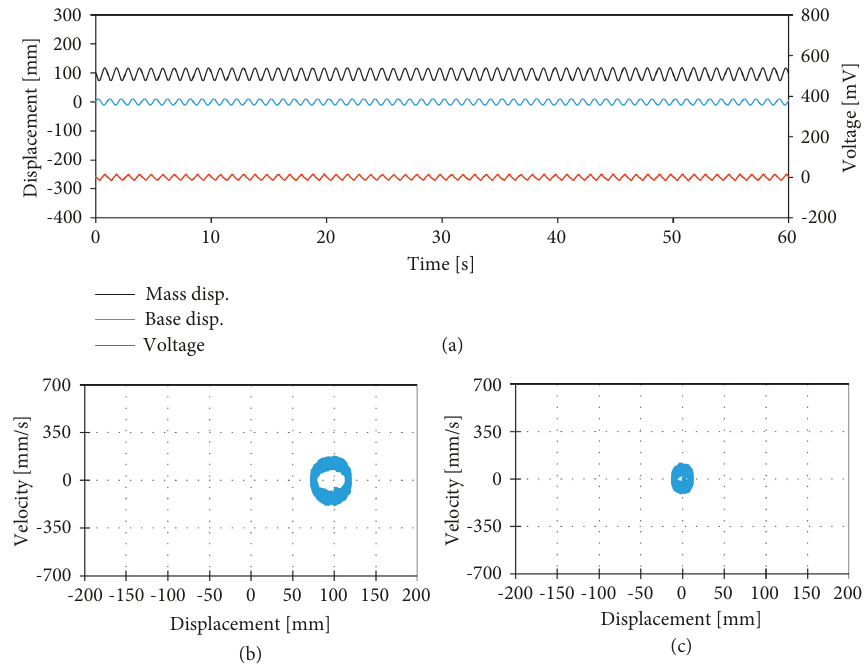
Figure 8: Measured results for response vibration displacement and vibration power generation for vibration with a periodic signal at 1.00Hz. (a) Response vibration displacement results. (b) Diagram of displacement vs. velocity of vibration for the mass block. (c) Diagram of displacement vs. velocity of vibration for the